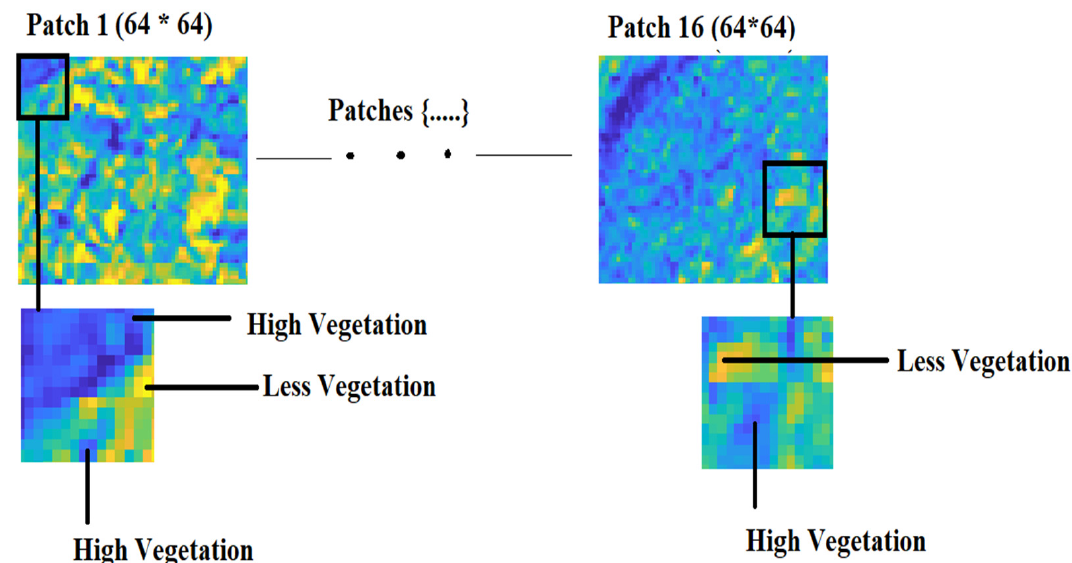
Figure 17. Trained patches for the area of Javadi Hills. Table 2. Hyperparameters of the Vision Transformer